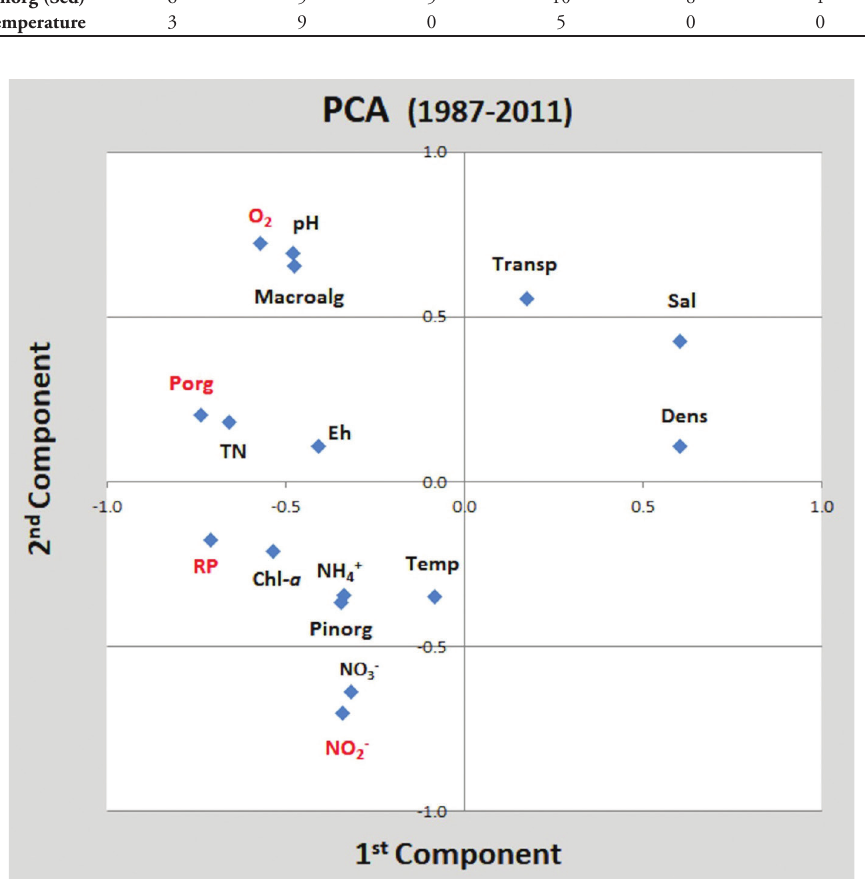
Figure 8. PCA bi-plot of the first two components during the whole 1987–2011